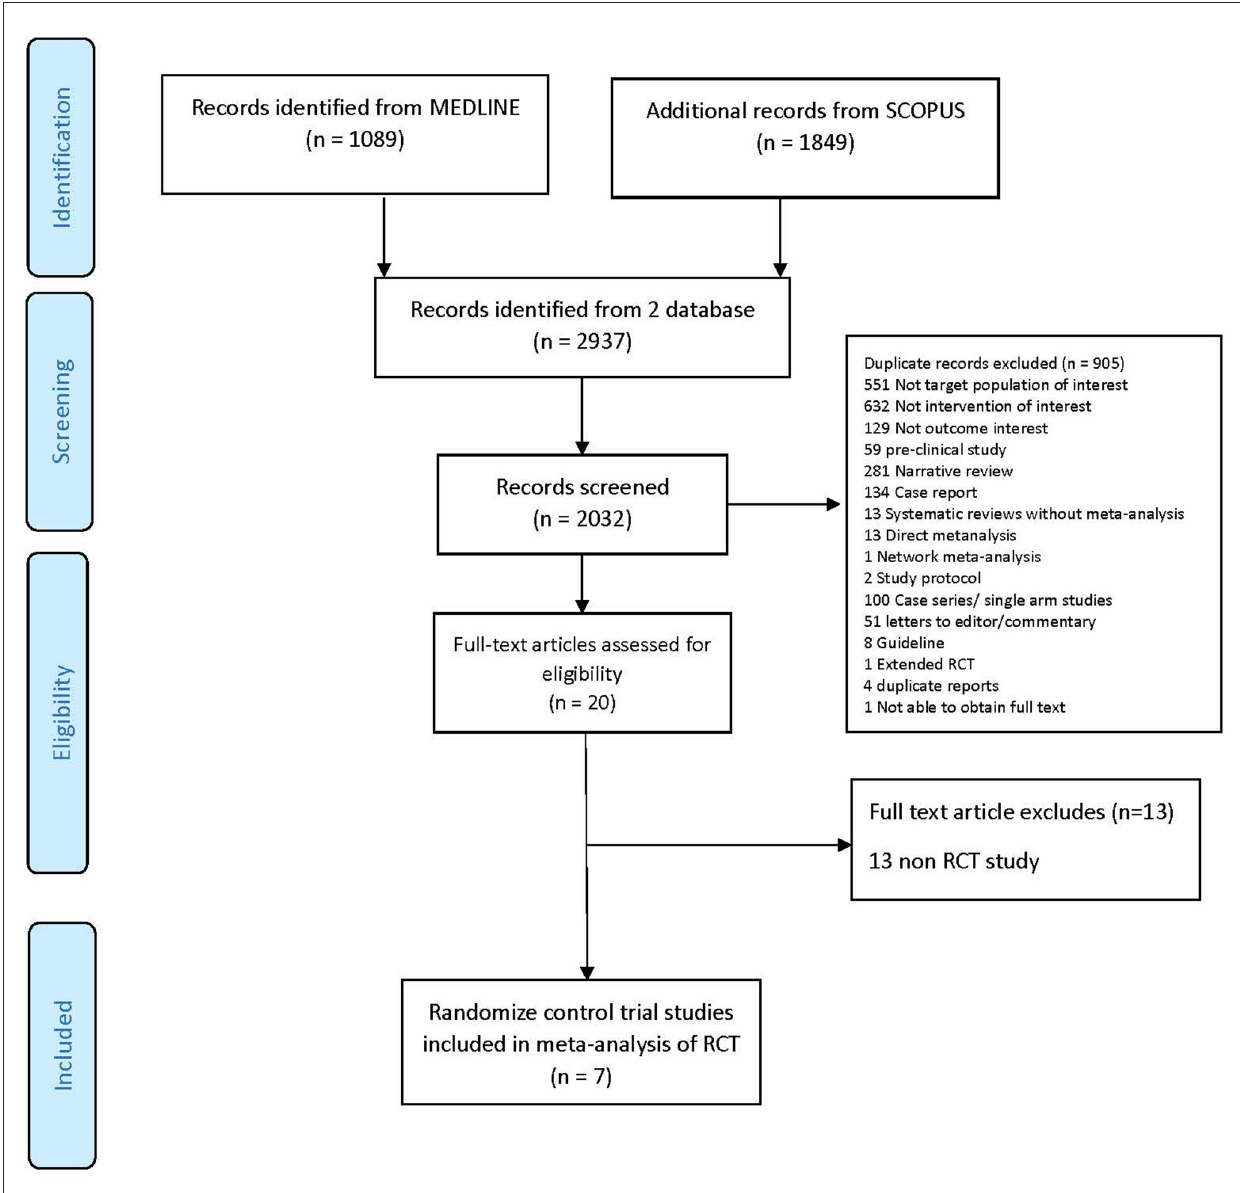
FIGURE1 PRISMA flow